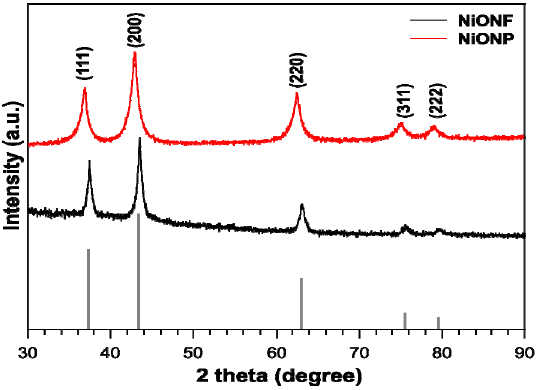
Figure 2. XRD for nickel oxide nanofibers (NiONF) and commercial nickel oxide nanoparticles (NiONP) [23].